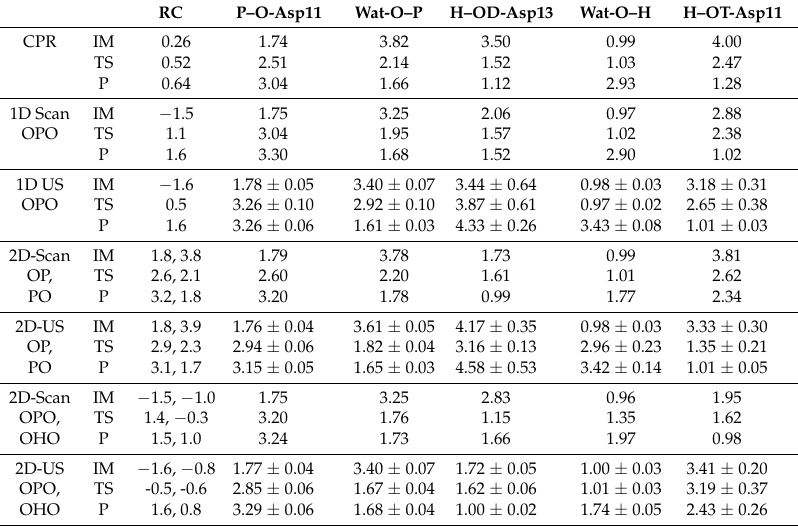
Table 3. Coordinates of end states (IM and P) and transition state (TS) along Step 2 of the phospho- hydrolysis reaction in PSP, computed with conjugate peak refinement (CPR), one- and two-dimensional potential energy scans, and by one- and two-dimensional umbrella sampling (US). Coordinate values from umbrella sampling are averaged over the simulation with the centre of the biasing potential at the reaction coordinate (RC or RC1 and RC2) values of the respective state (IM, TS, or P) on the free energy surface and may therefore differ from these values. OPO refers to the linear combination of P–O distances, [d(P–O-Asp11) − d(wat-O–P)], OHO to the linear combination of O–H distances,